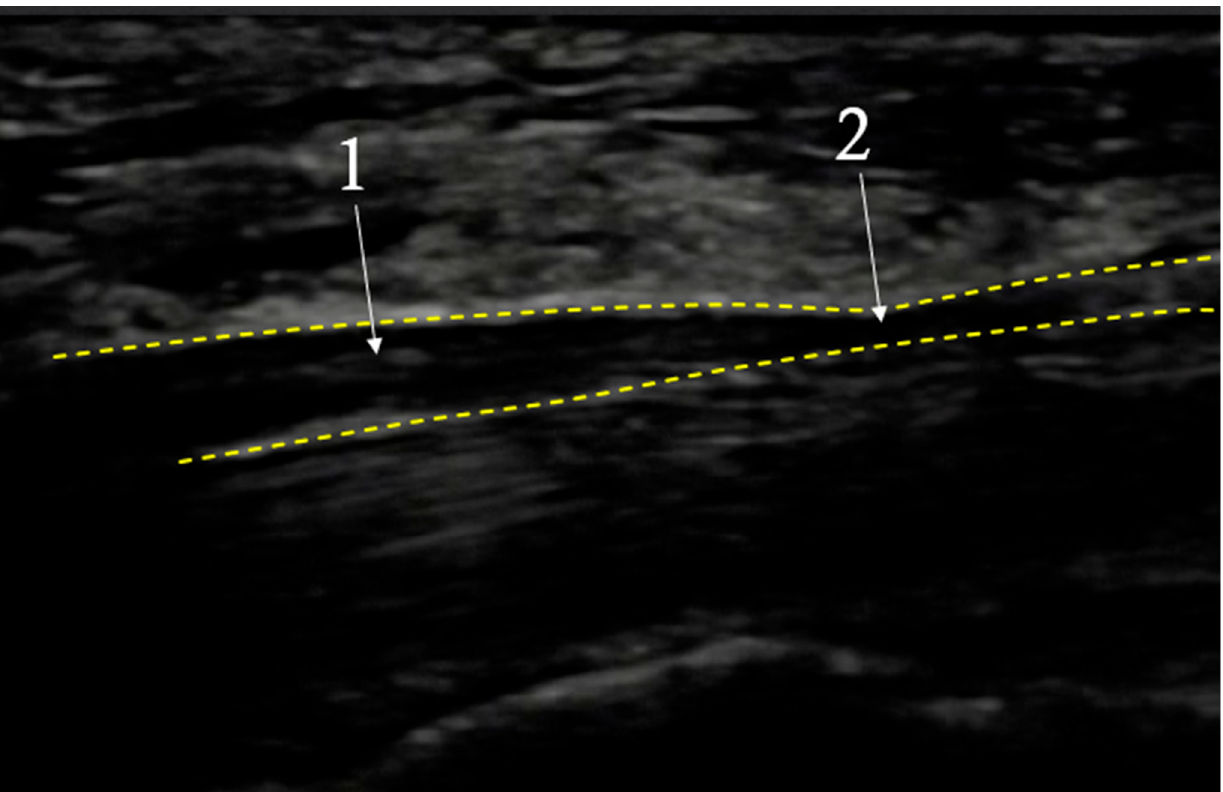
Figure 1. Exemplary image seen during USG examination of Carpal Tunnel Syndrome. CTS—dotted line; Medial Nerve (MN)—contours; 1—nerve dilatation before carpal tunnel; 2—nerve compression in carpal tunnel; longitudinal cross section.